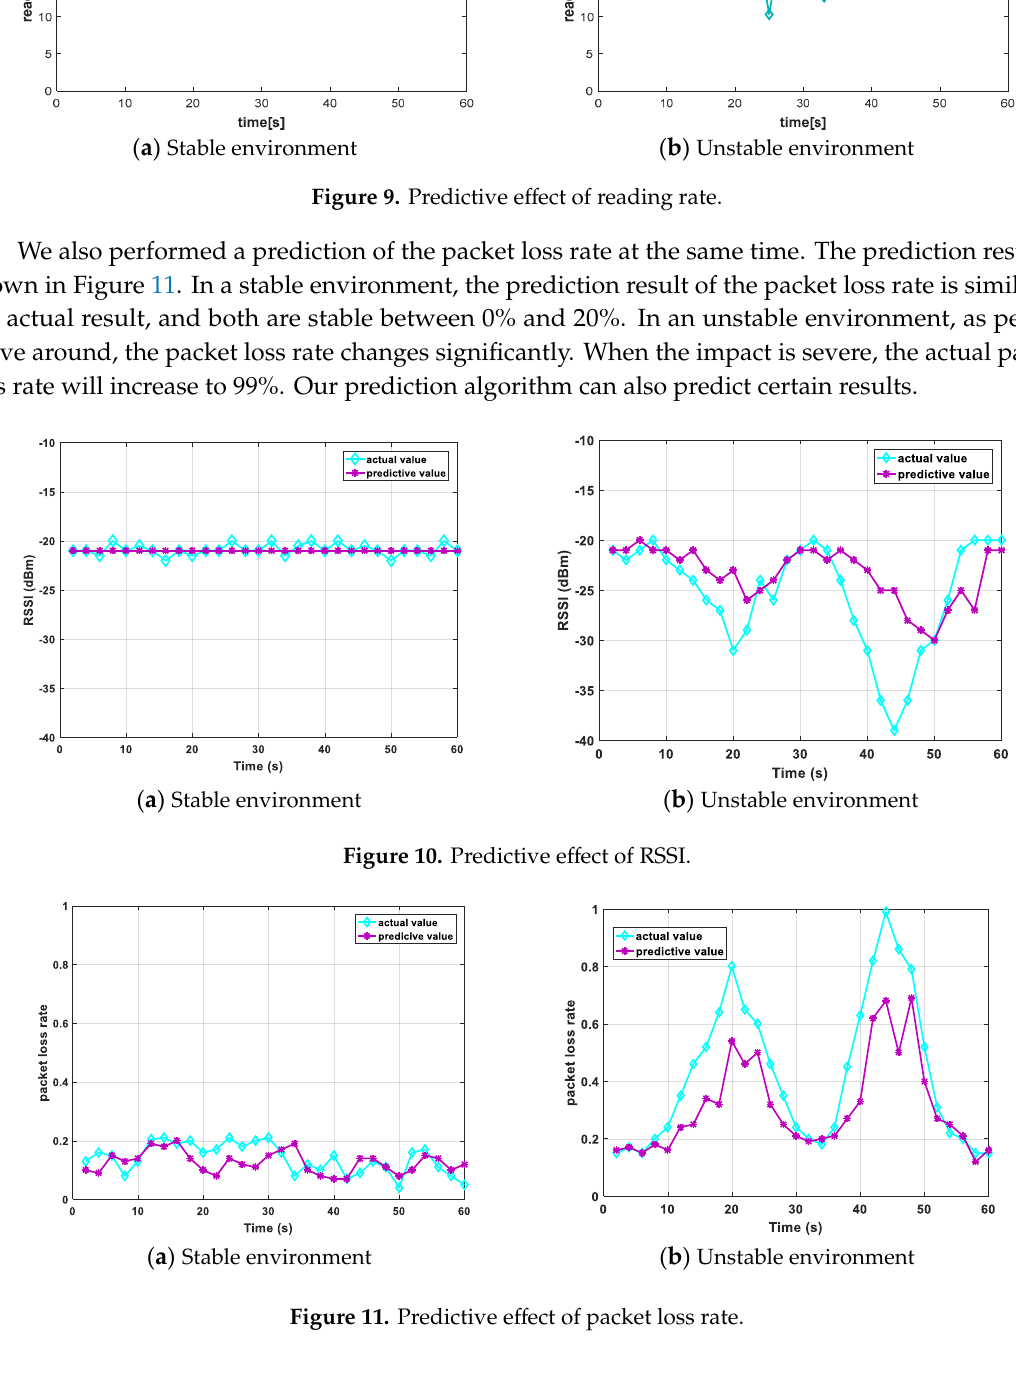
Figure 9. Predictive effect of reading rate.